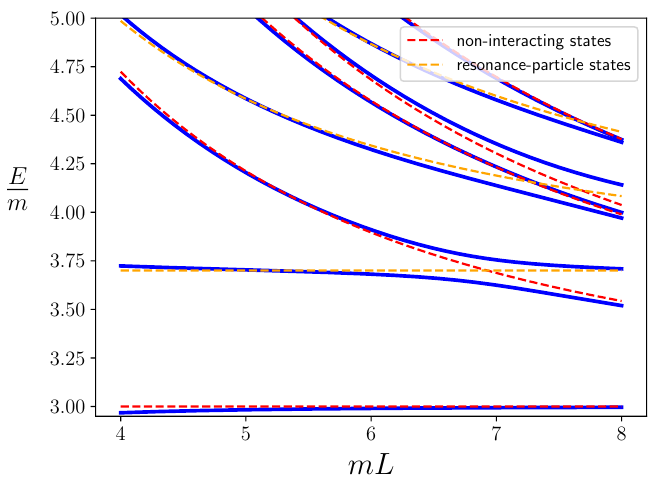
Figure 11 . Three-particle spectrum (solid blue lines) in the isotropic approximation in the presence of a two-particle resonance with g = 1, m R = 2 : 7 m and K df ; 3 = 0. Noninteracting three-particle states (red dashed lines) and noninteracting particle + resonance states (orange dashed lines) are shown for